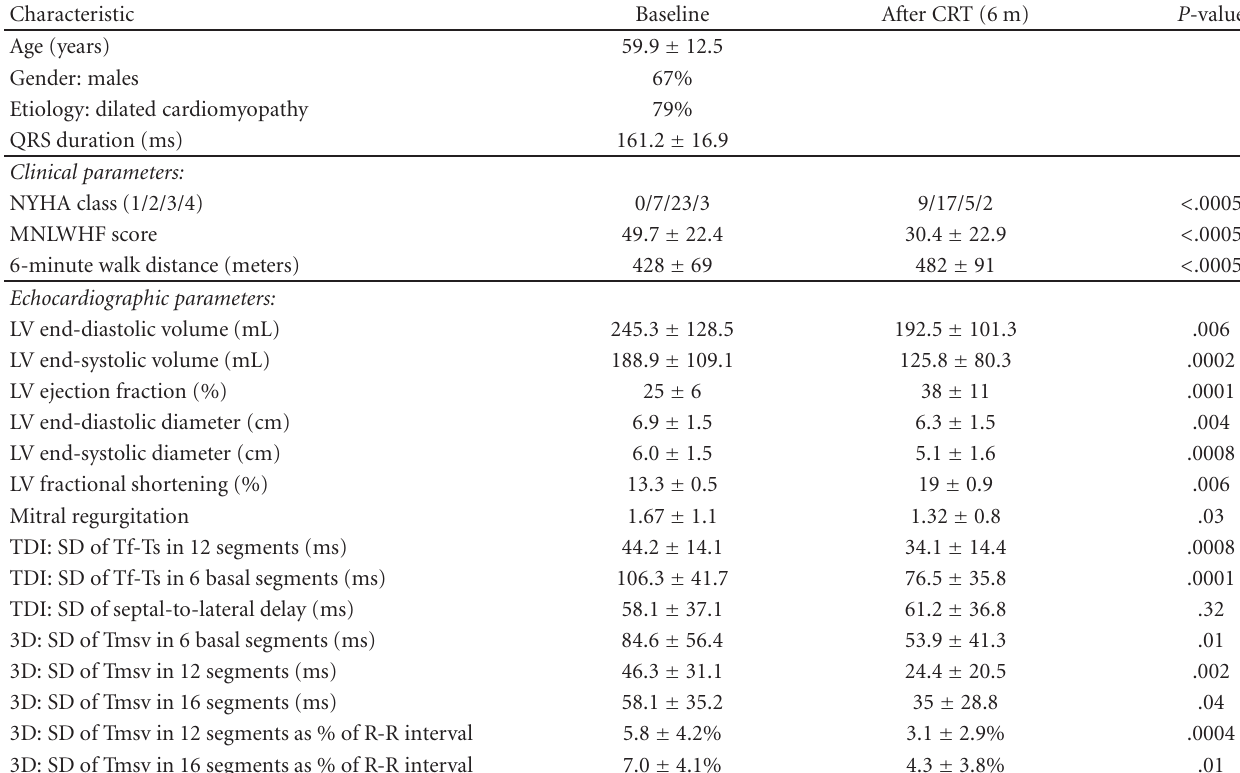
Table 1: Baseline characteristics and echocardiographic parameters pre-CRT and after long-term